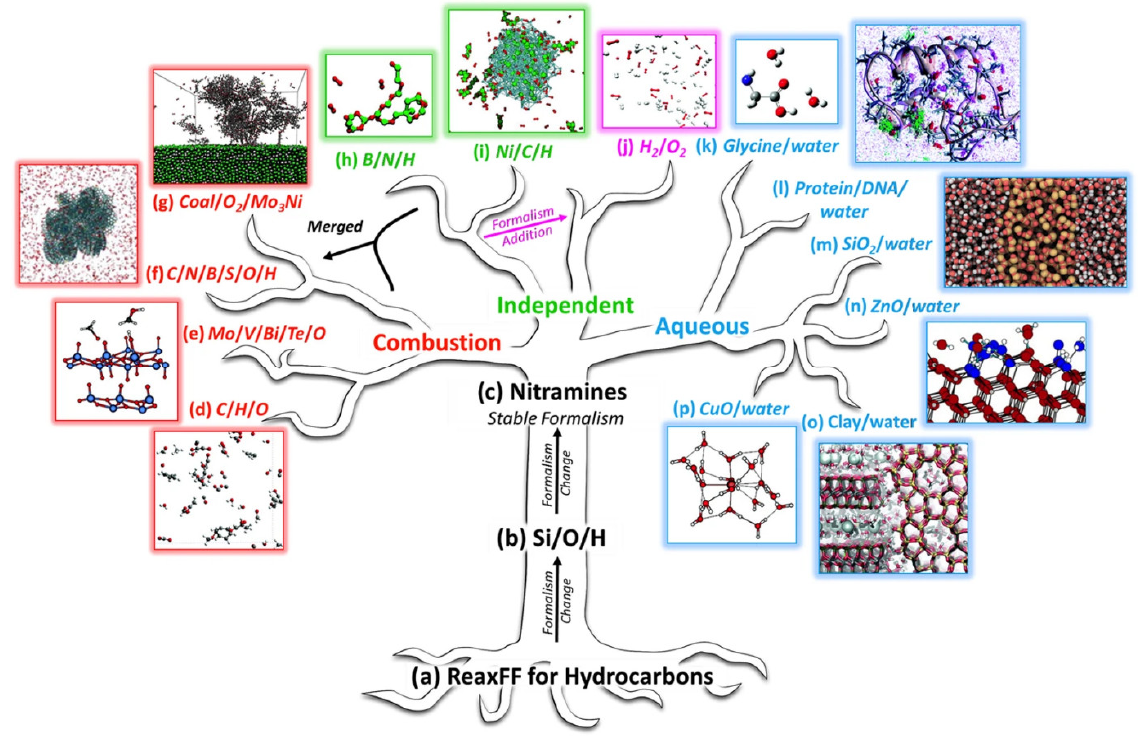
Figure 1. The development of ReaxFF [41] . Copyright 2016 Springer Nature.